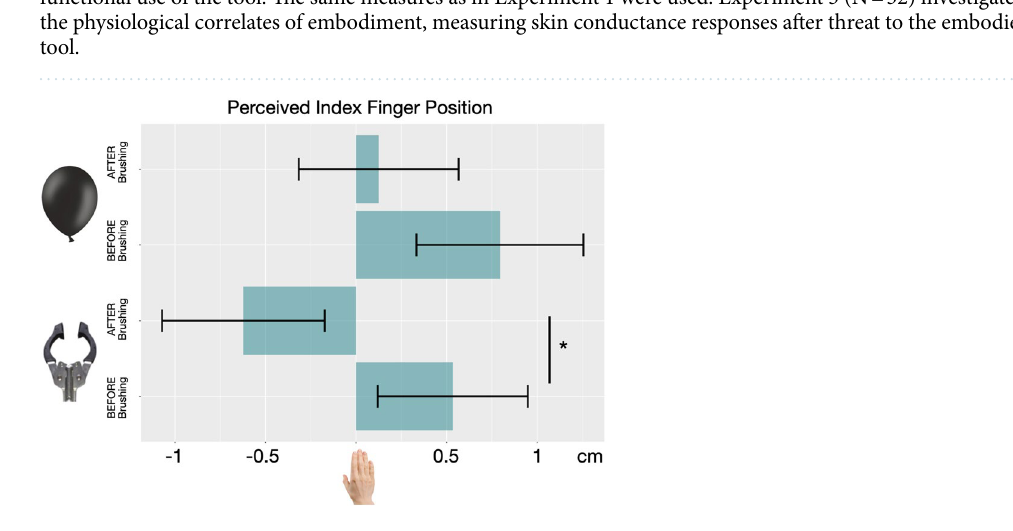
Figure 2. Perceived index finger position. In experiment 1, after 2 min of synchronous brushing, participants (N = 16) localised their index finger drifted toward the tool. The same participants did not show significant drift after synchronous brushing of the balloon. Error bars indicate 95%